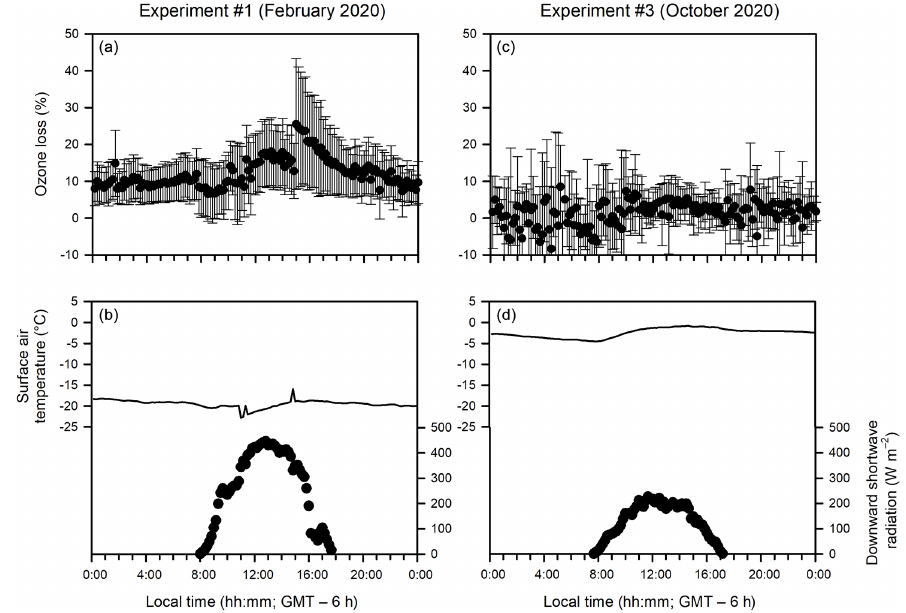
Figure 8. Diurnal patterns of (a, c) ozone loss (%) (measured as the ozone difference in the in-tube air between the UV-transmitting and UV-blocking tubes at 10cm above the sea ice or water surface) and (b, d) meteorological conditions during the ice-covered (a, b) and open water (c, d)